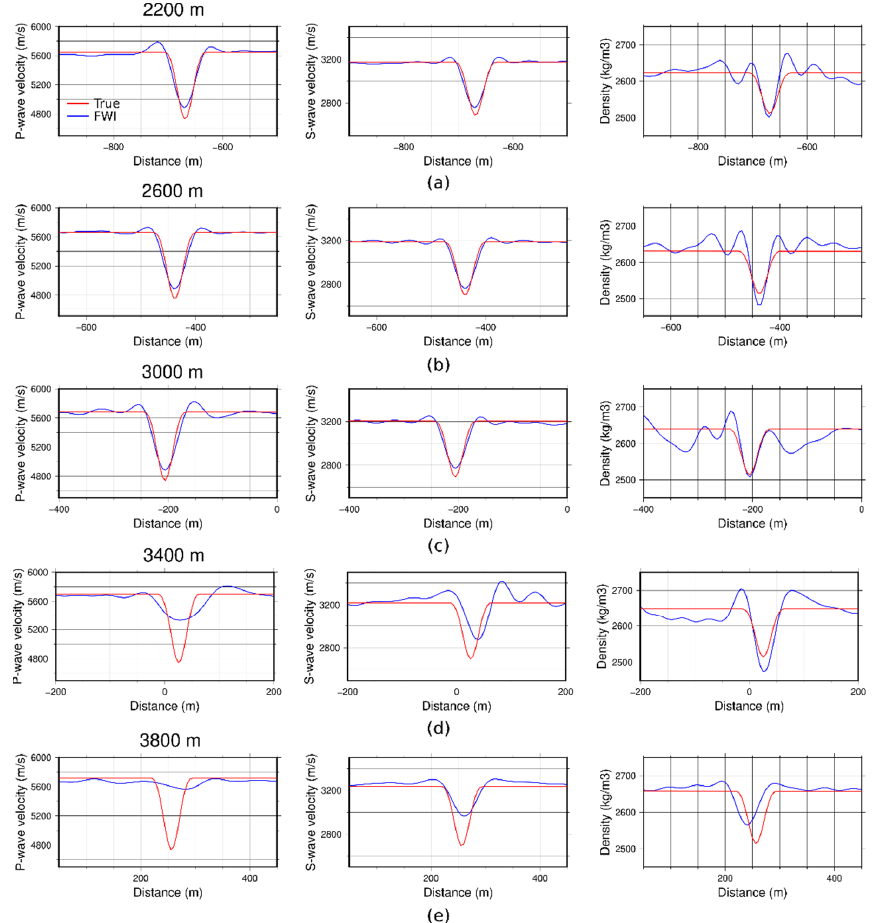
Figure 12. The estimated P- (right) and S-wave (middle) velocities and density (right) contrasts for five representative depths; ( a ) at the upper extremity (2200 m), ( b ) at 2600 m, ( c ) crossing the well at 3000 m, ( d ) at 3400 m and ( e ) the lower fault extremity at 3800 m. The fault no. 4 has been modelled and inverted (Figure 7), where the FWI image is shown in Figure 8b. Note that the true curves has no rectangular shape, because we smoothed the model to reduce diffractions arising from the model pixels. A filter smoothing 4x4 pixels (i.e., 20 × 20 m) have been applied to smooth the final physical, P-, S- waves and density models.